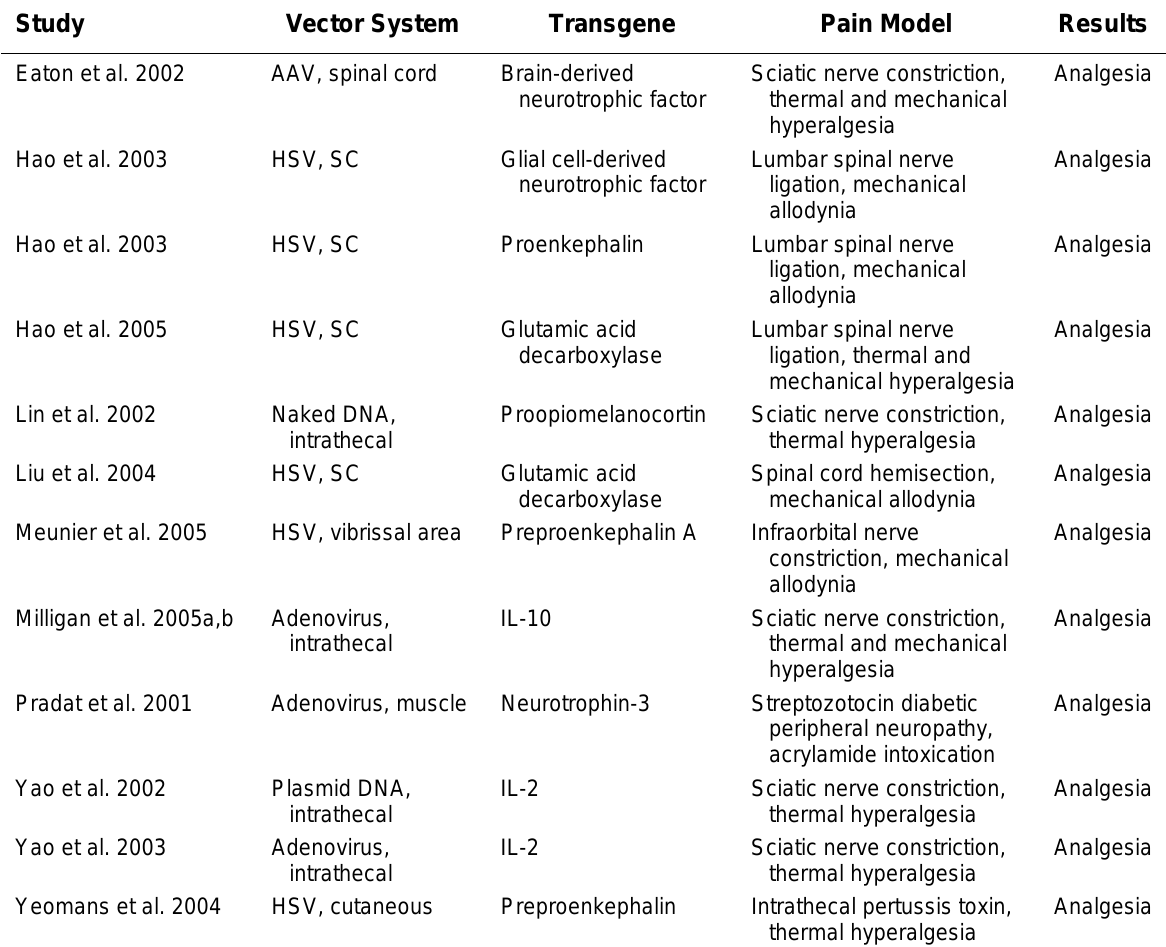
Effect of Gene Therapy on Neuropathic Pain Models in